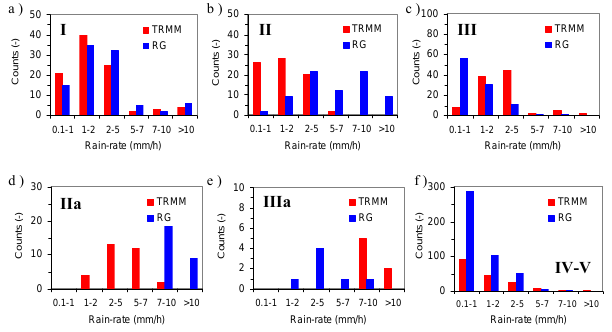
Fig. 8: TRMM-RG records repartition as a function of rain-rate and following to the TRMM-RG Fig. 8. TRMM-RG records repartition as a function of rain-rate and classification into five categories: a) I (95). b) II (76). c) III (100). d) IIa (31). e) IIIa (7). f) IV (180) following to the TRMM-RG classification into five categories: (a) I and V (448). (95). (b) II (76). (c) III (100). (d) IIa (31). (e) IIIa (7). (f) IV (180) and V